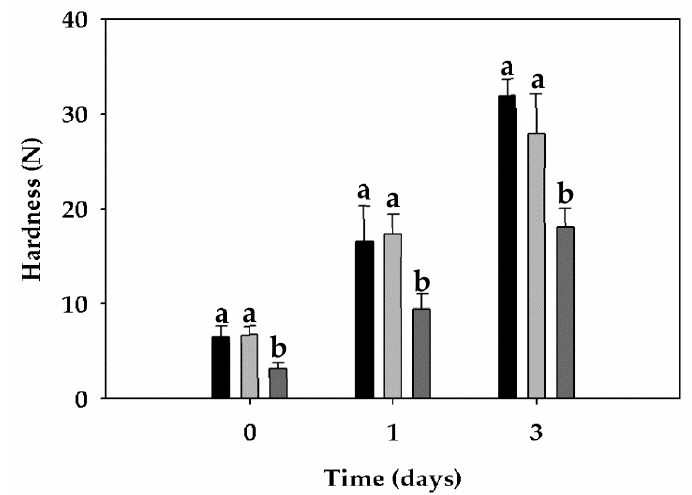
Figure 7. Crumb firmness properties of loaves obtained from refined wheat flour (black), with bran from un-sprouted wheat (light grey), or bran from sprouted wheat (dark grey) during storage. Values associated with different letters (a, b) in the same day are significantly different (one-way ANOVA, LSD test, p ≤ 0.05).